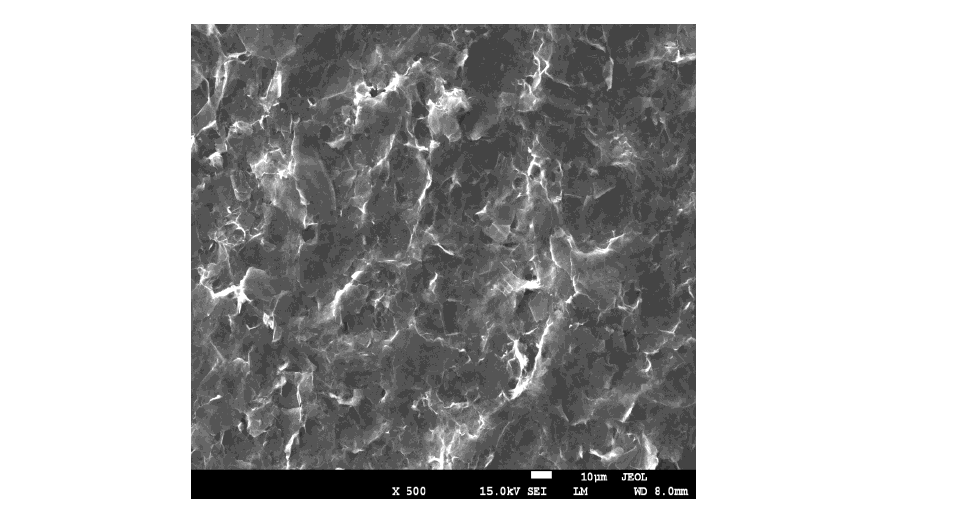
Figure 3. The example of SEM image of a film composed of GO + and GO − deposited at silicon wafer. Image magnification 500×.